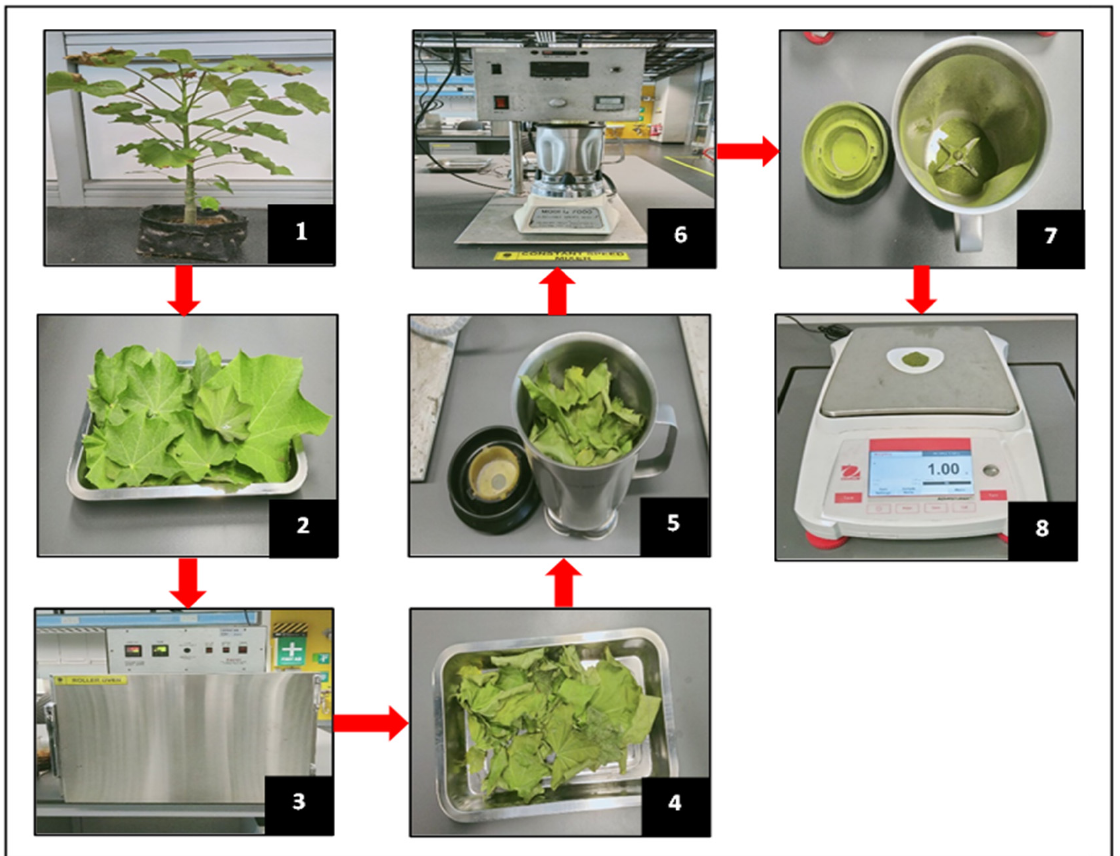
Figure 7. Process of powdered Jatropha leaves.